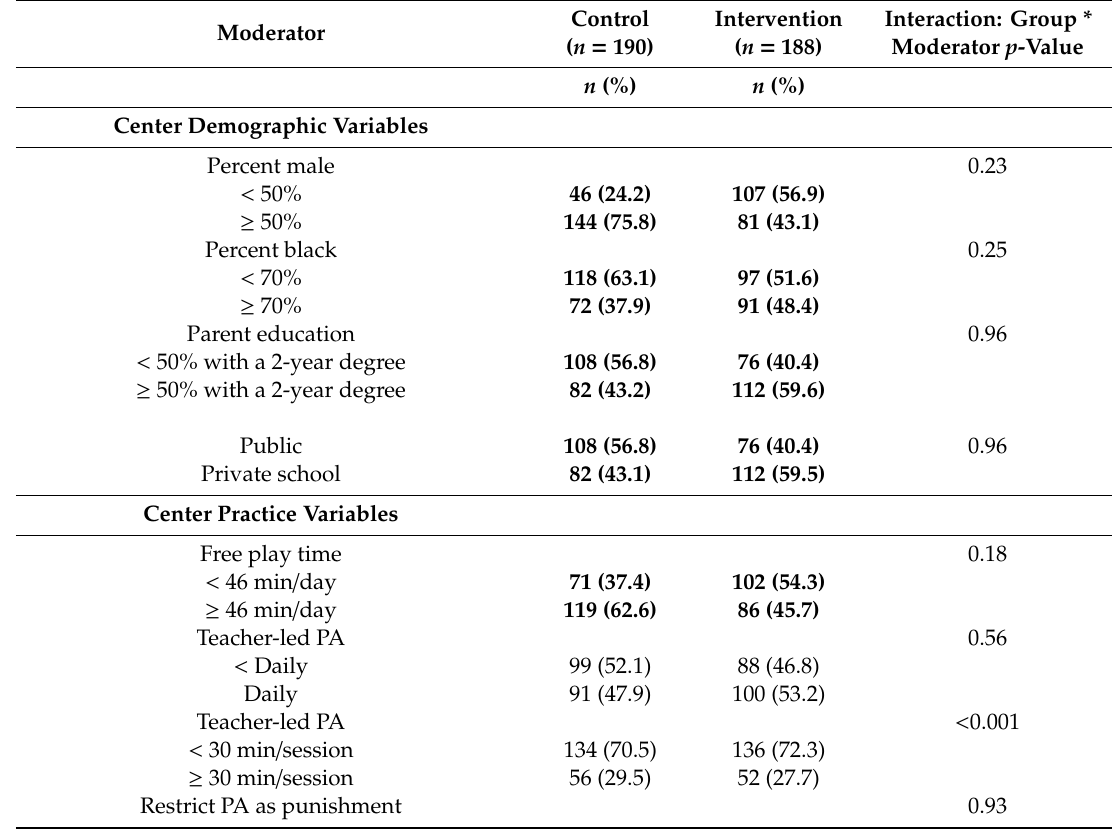
Table 2. Sample size, frequencies of moderator variables by group and p -values from analysis of covariance (ANCOVA)